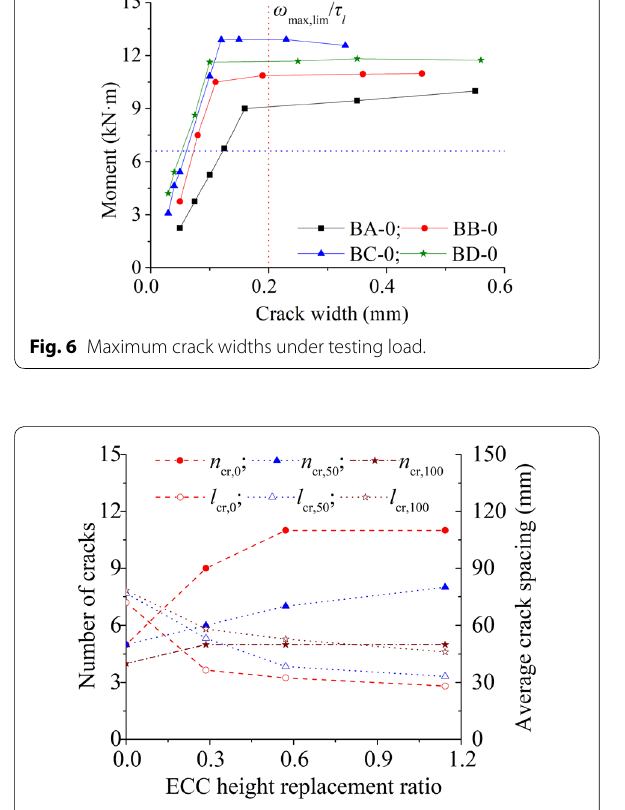
Fig. 7 Average crack spacing and number of cracks.